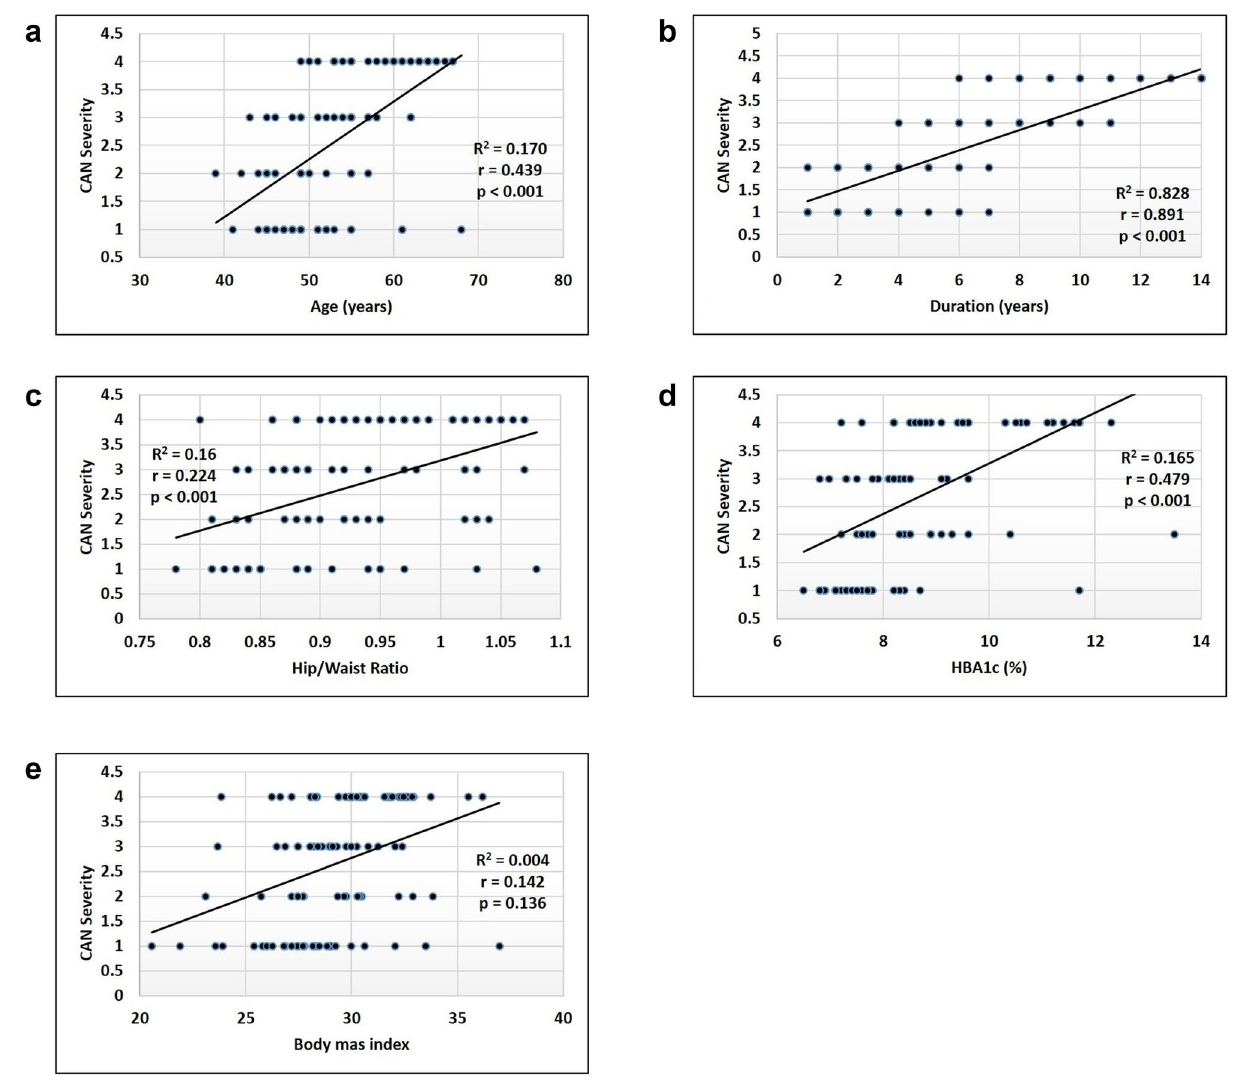
Figure 2. ( A ) correlation between CAN severity and patient’s age ( B ) correlation between CAN severity and diabetes duration ( C ) correlation between CAN severity and waist-hip ratio ( D ) Correlation between CAN severity and HbA1c level ( E ) Correlation between CAN severity and body mass